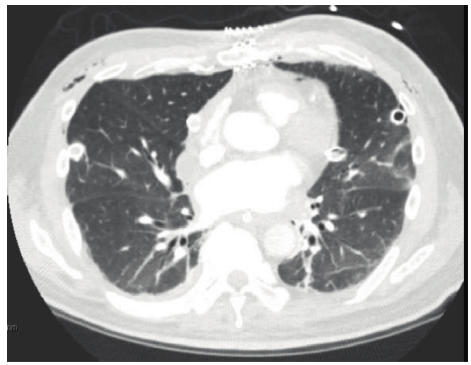
Figure 2: Lung CT scan after bilateral lung